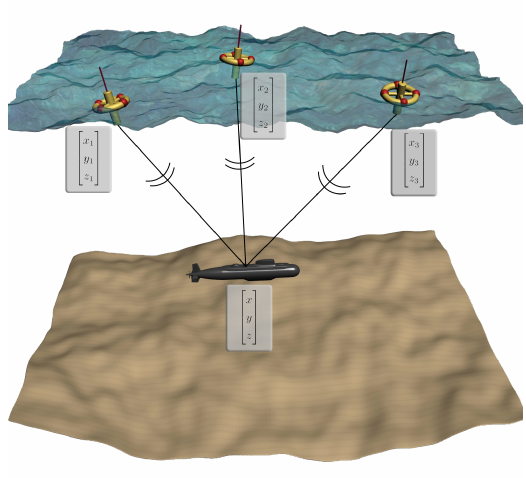
Figure 2. AUV localization with three surface